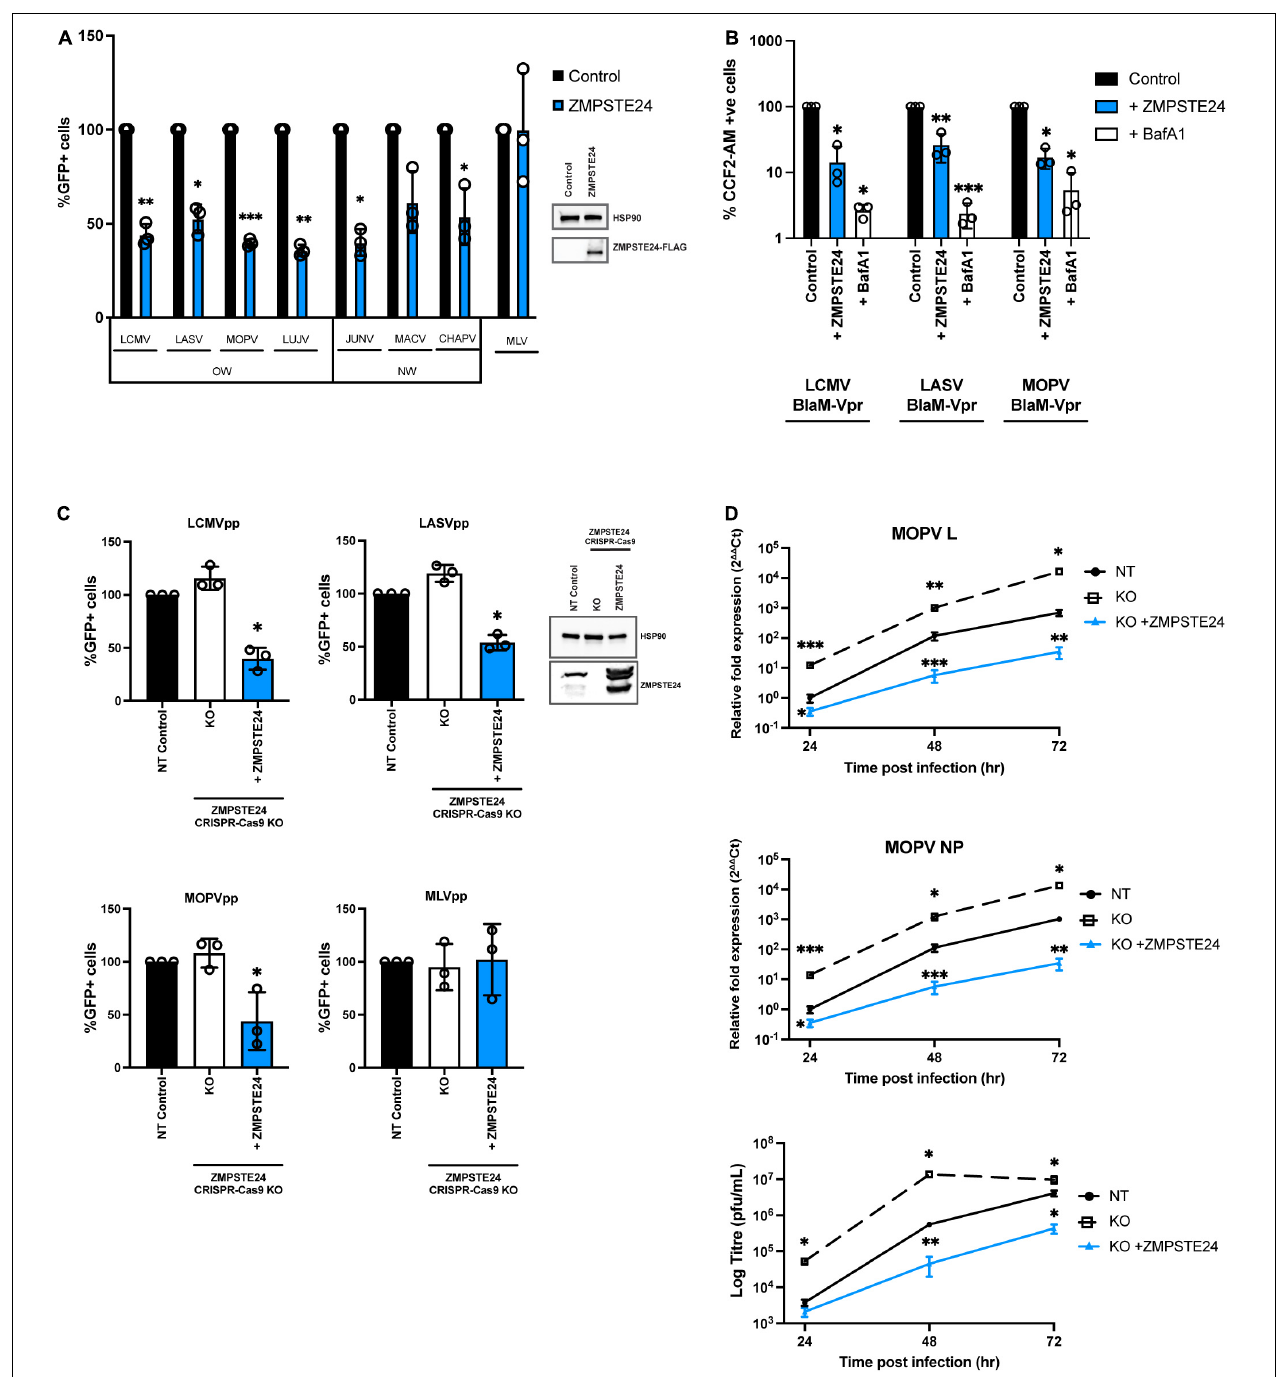
FIGURE 1 | Arenavirus entry and replication is inhibited by ZMPSTE24. (A) GFP-containing GP pseudoparticles (GPpp) from Old world (OW) and New world (NW) arenaviruses or an amphitropic murine leukaemia virus (MLV) control were used to infect A549 cells stably expressing ZMPSTE24-FLAG or an empty vector control (inset). GPpp entry was measured by flow cytometry and expressed as %GFP + cells relative to controls. (B) Control or ZMPSTE24 expressing A549 cells were mock-infected or infected for 3 h with LCMV, LASV or MOPV GP-pseudotyped viruses carrying the BlaM-Vpr fusion protein at 100 ng p24. Cells were loaded with fluorescent substrate of beta-lactamase, CCF2-AM and virus entry into the cytoplasm was assessed by cleaved CCF2-AM fluorescence at 450 nm by flow cytometry. (C) A549 cells stably expressing either non-targeting (NT) control, ZMPSTE24 CRISPR-Cas9 knockout (KO) or ZMPSTE24 KO with ZMPSTE24-FLAG overexpression, were infected with arenavirus GPpp or MLVpp control and infection was measured by flow cytometry. (D) Cells in panel C were infected with live MOPV (MOI = 0.01). Relative fold expression of MOPV L or NP genes were measured by RT-qPCR from extracted RNA and infectious virus production was measured by plaque assay of cell supernatants at 24, 48, and 72 h post infection. Data are shown as mean ± SE (standard error) of n = 3 independent experiments. Significance is indicated as p -values: *** p < 0.0001, ** p < 0.001, * p < 0.05.